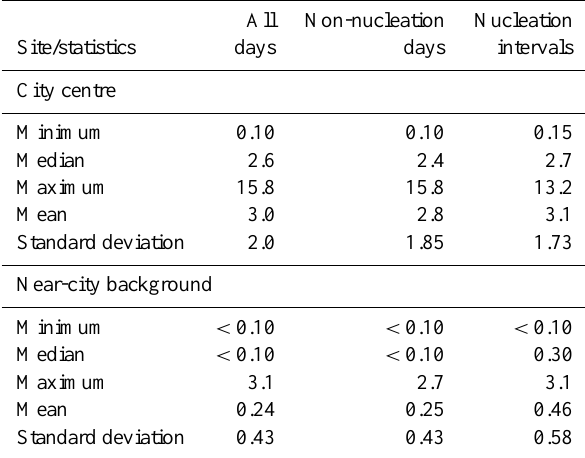
Table 1. Ranges, medians, and means with standard deviations of the wind speed for all measurement days, and separately for non- nucleation days, for nucleation, and for growth intervals of class 1A events at the city centre and near-city background.